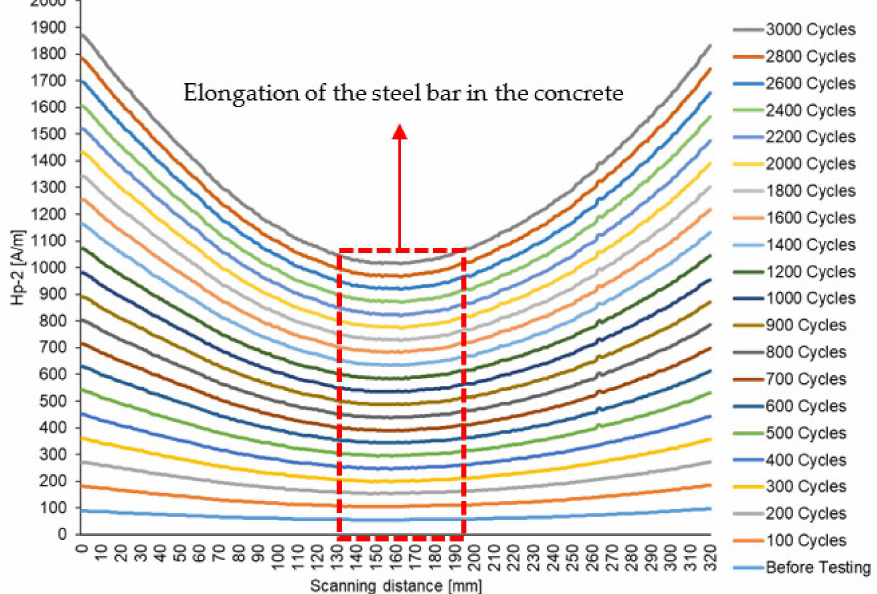
Figure 9. Magnetic flux leakage signals with scanning interval distances showing the stress concen- tration zone on the beam.